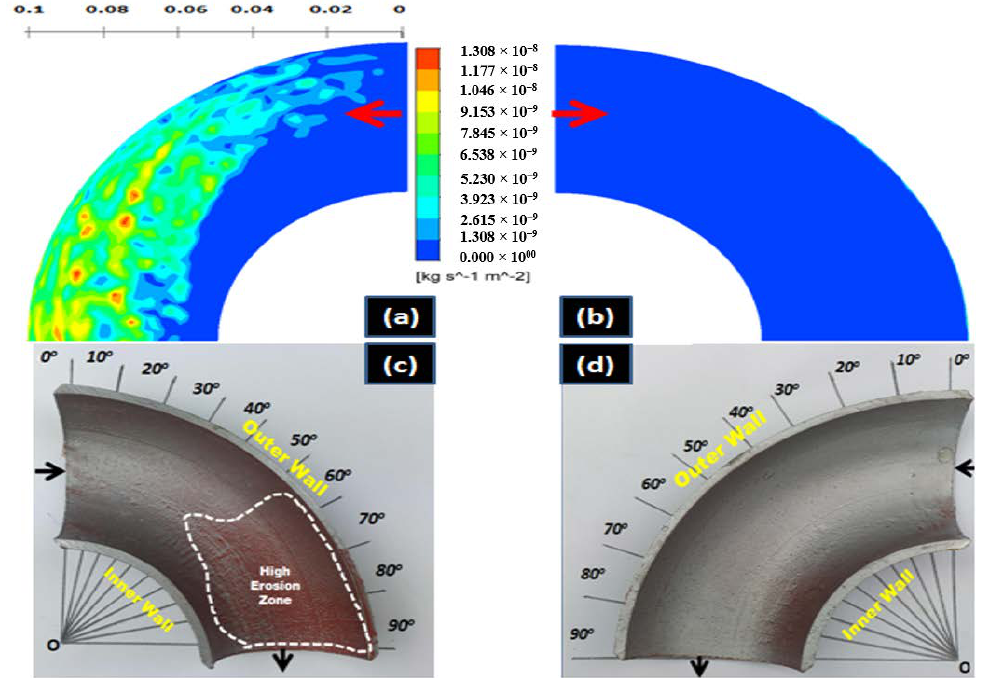
Figure 11. Comparison of erosion pattern for 90° elbow, between prediction and MPM experiments at 0.5 m/s. ( a ) bottom section (CFD) ( b ) upper section (CFD) ( c ) bottom section (MPM) ( d ) upper section (MPM).